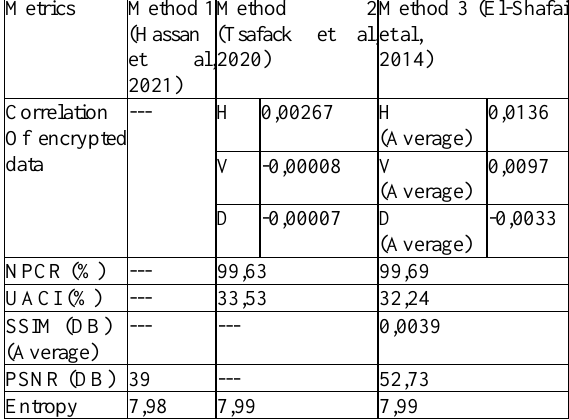
Table 1 : The comparison of metric’s evaluation